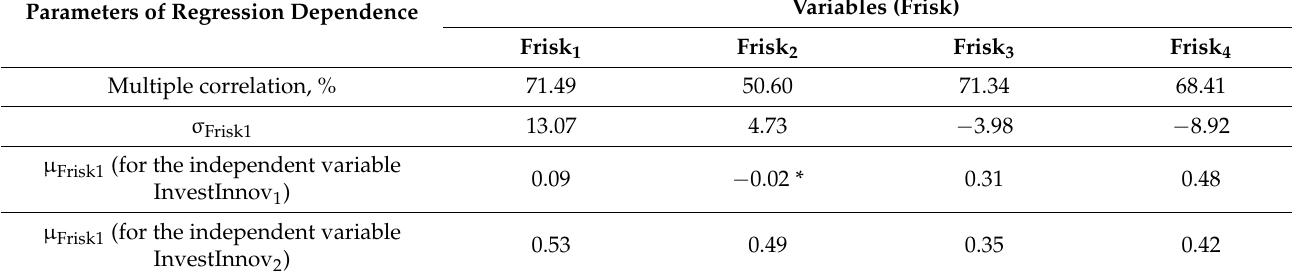
Parameters of Regression